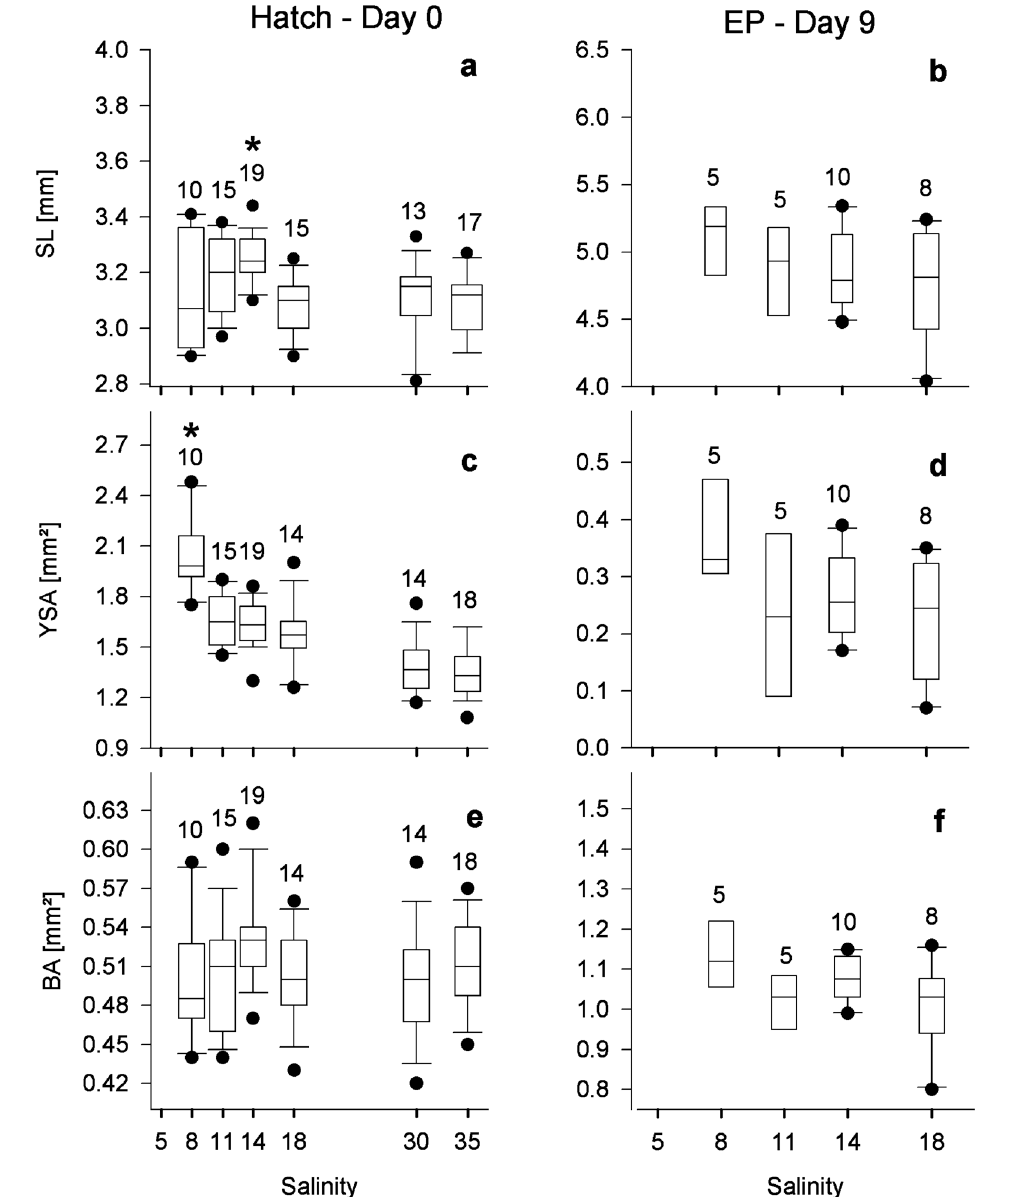
F IG . 4. – Yolk sac larval morphometric traits (standard length (SL, mm), yolk sac area (YSA, mm²) and body area (BA, mm²)) of Baltic Sea sprat larvae originating from the incubation trial (trial 3), at hatch (Day 0, left panels a, c, e) and at eye pigmentation (EP- Day 9, right panels b, d, f). Box-Whisker plots show the median as a black bar, the 25 th and 75 th percentiles as vertical boxes with the 10 th and 90 th percentiles as error bars. Numbers of measured larvae are presented above each Whisker. Values at EP at salinities of 30 and 35 were excluded in b, d and f. due to high mortalities. An asterisk marks a significant difference between